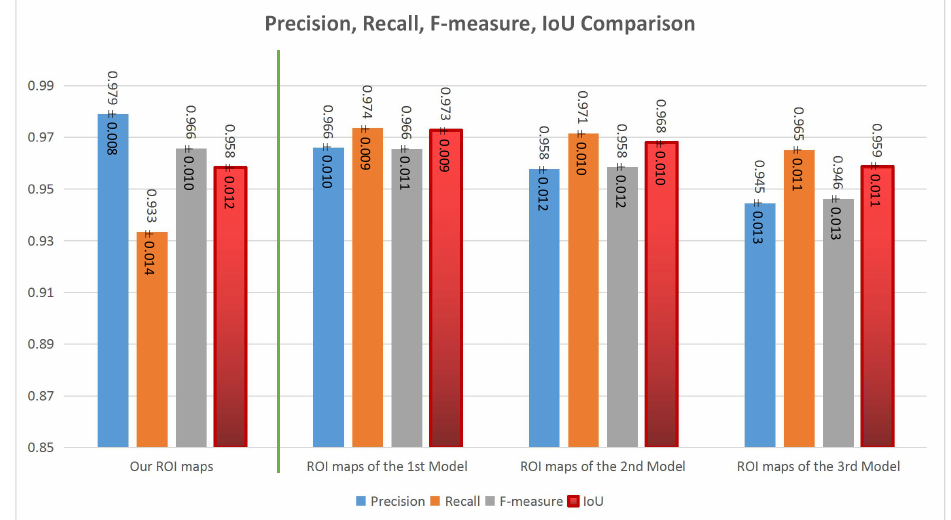
Figure 13. Evaluations for our handcrafted ROIE method (on the left side) and our deep models (on the right